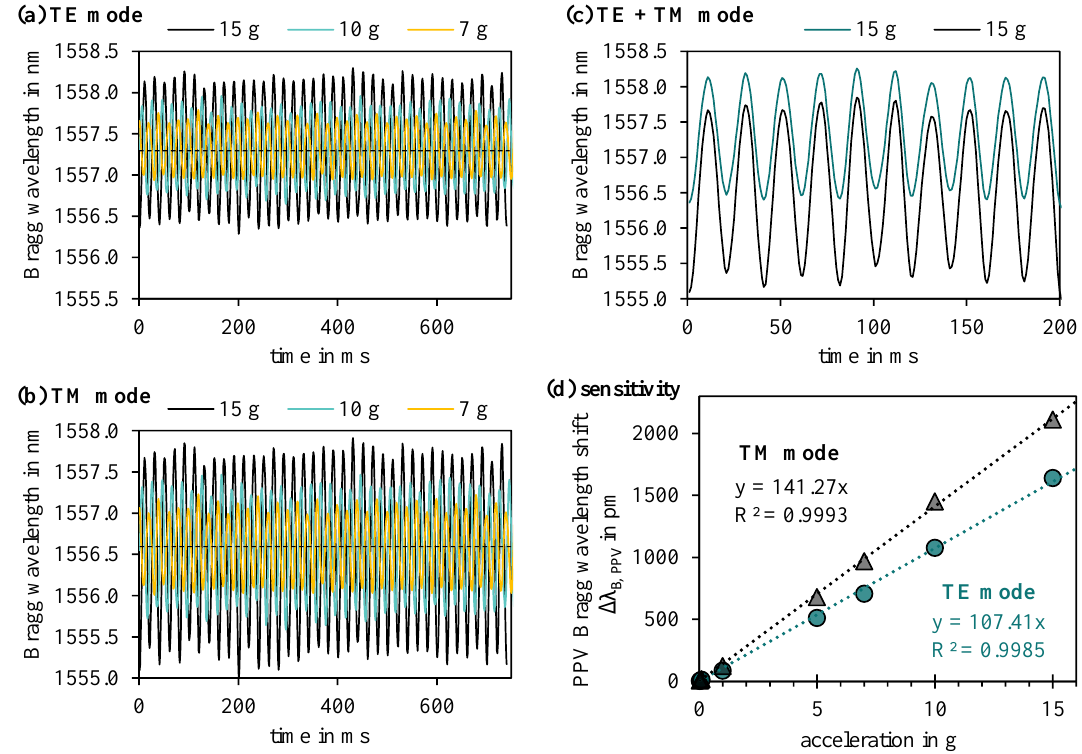
Figure 5. Sensor response to different impinged acceleration values with a precisely calibrated frequency of 50 Hz. ( a ) Temporal Bragg wavelength signal of the TE mode; ( b ) temporal Bragg wavelength signal of the TM mode; ( c ) well-separated TE and TM modal reflection signals even at high acceleration value of 15 g; ( d ) linear accelerometer sensitivities of the fundamental TE and TM modal reflection.